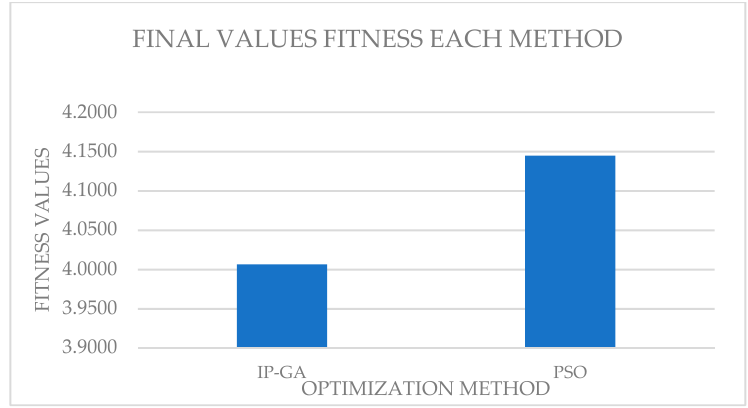
Figure 9. Value result of the function fitness for the proposed methods .